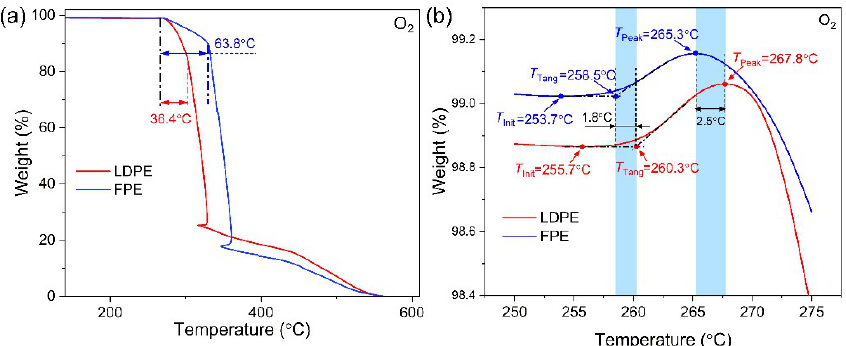
Figure 9. Thermal degradation curves of FPE and LDPE in TGA tests under O 2 atmosphere ( a ) 40–600 ◦ C, ( b ) 250–275 ◦